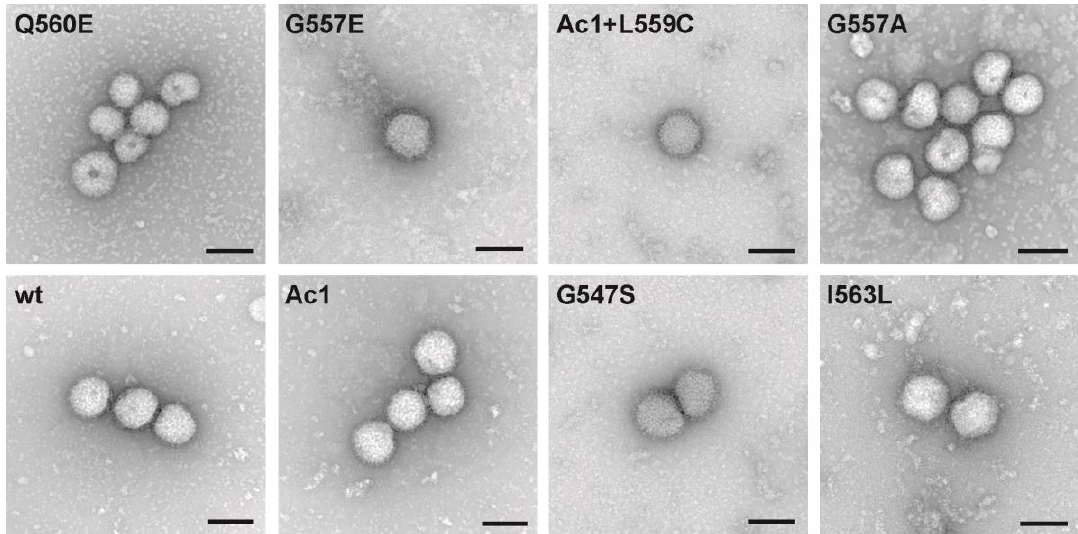
Figure 5. Characterisation of WSN wild type and mutants by negative staining transmission electron microscopy. Representative negative stain images of the indicated virus particles harvested from the supernatant of infected MDCK cells. Scale bars = 200 nm. Differences in particle appearance are not due to morphological changes but to slight modifications of microscope settings and staining conditions of the virus suspensions. Occasionally, filamentous and aberrant formed particles